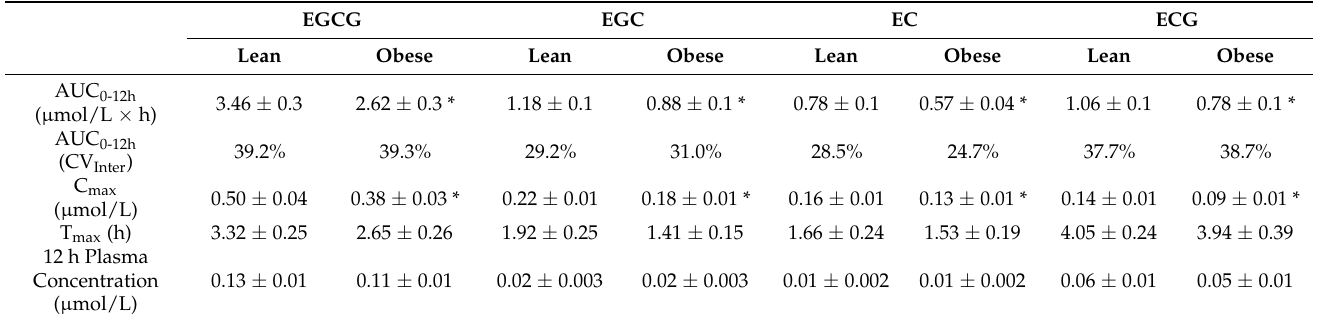
Table 2. Pharmacokinetic parameters of plasma catechins.